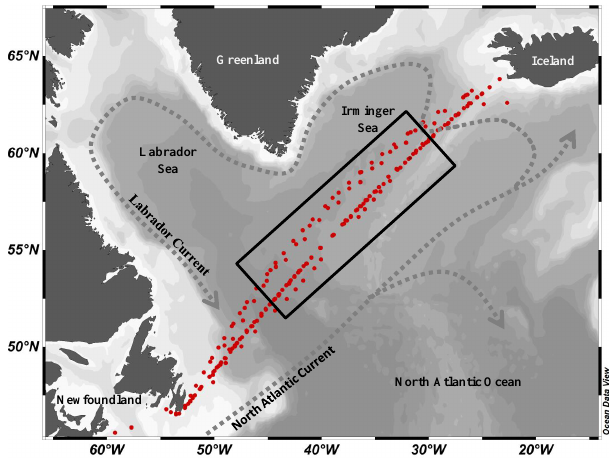
Fig. 1: Cruises track where δ 13 C DIC was sampled in 2005-06 and 2010-12 (red dots). Dashed lines indicate schematically surface main currents in the North Atlantic Ocean. The interior of the North Atlantic subpolar gyre (NASPG, 53 ◦ N–62 ◦ N), our study area, is delimited by the black